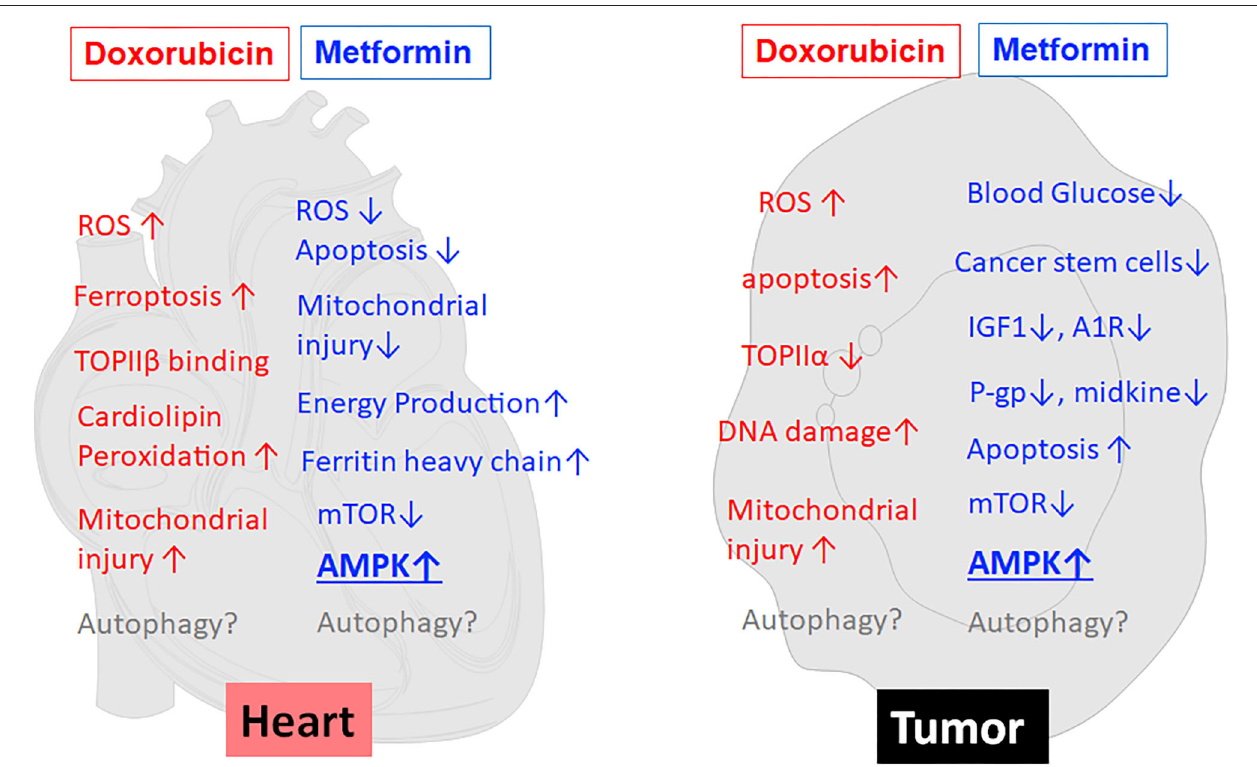
FIGURE 2 | MET reduces the toxic effects of DOX on cardiomyocytes but concurrently enhances the anticancer effects of DOX on tumor cells. As shown in the left panel (heart), MET antagonizes DOX cardiotoxicity through several mechanisms, including attenuation of ROS generation and oxidative stress, inhibition of mitochondrial damage and maintenance of energy production, increased expression of ferritin heavy chain, and activation of AMPK. At the same time, MET enhances DOX antitumor effects (tumor, the right panel) through reduction of blood glucose, inhibition of cancer stem cells, reduction of IGF-1, modulation of adenosine A1 receptor (A1R), down-regulation of drug-resistant gene P-glycoprotein (P-gp), induction of apoptosis, inhibition of midkine, inhibition of mTOR, and activation of AMPK. Of note, AMPK activation has been suggested to be the major mechanism that mediates both the anti-tumor and cardioprotective effects of MET. On the other hand, the effects of MET on autophagy/mitophagy are not very clear. ↑ , increase or upregulation; ↓ , inhibition or downregulation; ROS, Reactive oxygen species; TOPII, Topoisomerase II; A1R, Adenosine A1 receptor; IGF1, Insulin-like growth factor 1; P-gp,